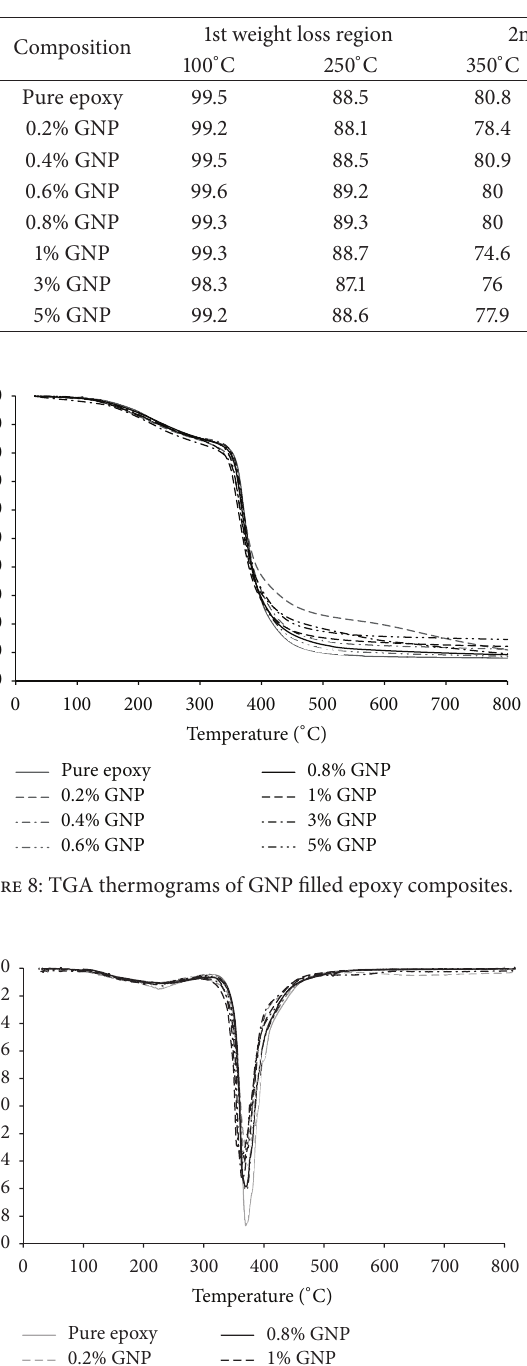
Table 2: Remaining weight percentage (%) of GNP filled epoxy composites at different temperature ( ∘ C).